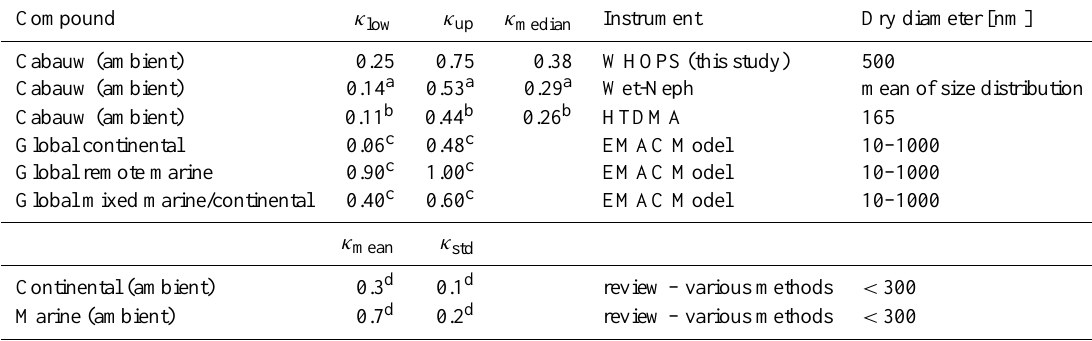
Table 2. κ values derived from different measurements at the CESAR site in Cabauw in this and previous studies plus simulated global values.